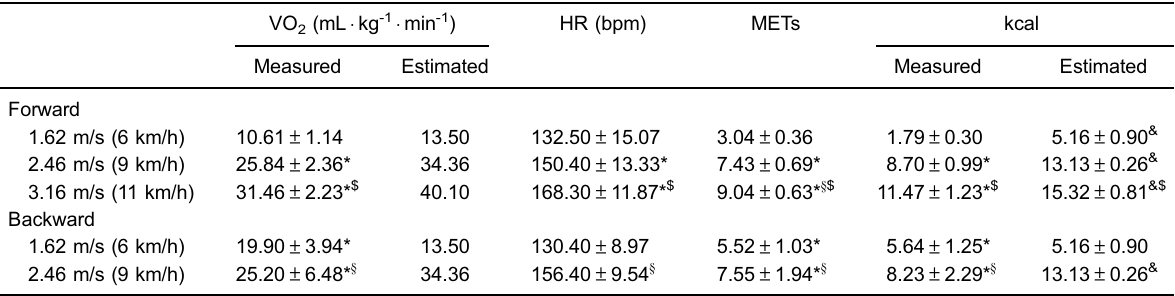
Table 1. Values of oxygen uptake (VO 2 ), metabolic equivalents (METs), kilocalories (kcal) and heart rate (HR) in forward and backward movements of soccer